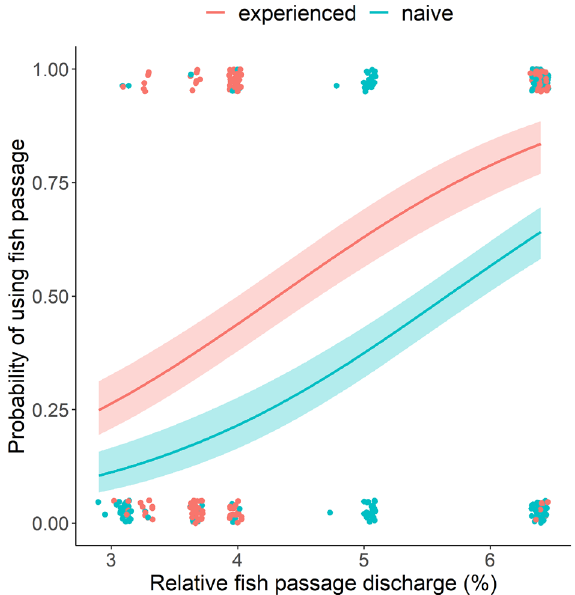
Figure 3. Predicted fish passage migration probability for experienced (red line) and naive (blue line) Atlantic salmon smolts at Rygene hydropower plant as a function of water allocation, as derived from the selected binomial GLM reported in Table 3. Shaded areas represent 95% confidence bounds including the distribution of individual fish passage- (y = 1) and turbine migrants (y = 0) at different discharge regimes (the observations have been x–y-jittered to reveal overlapping